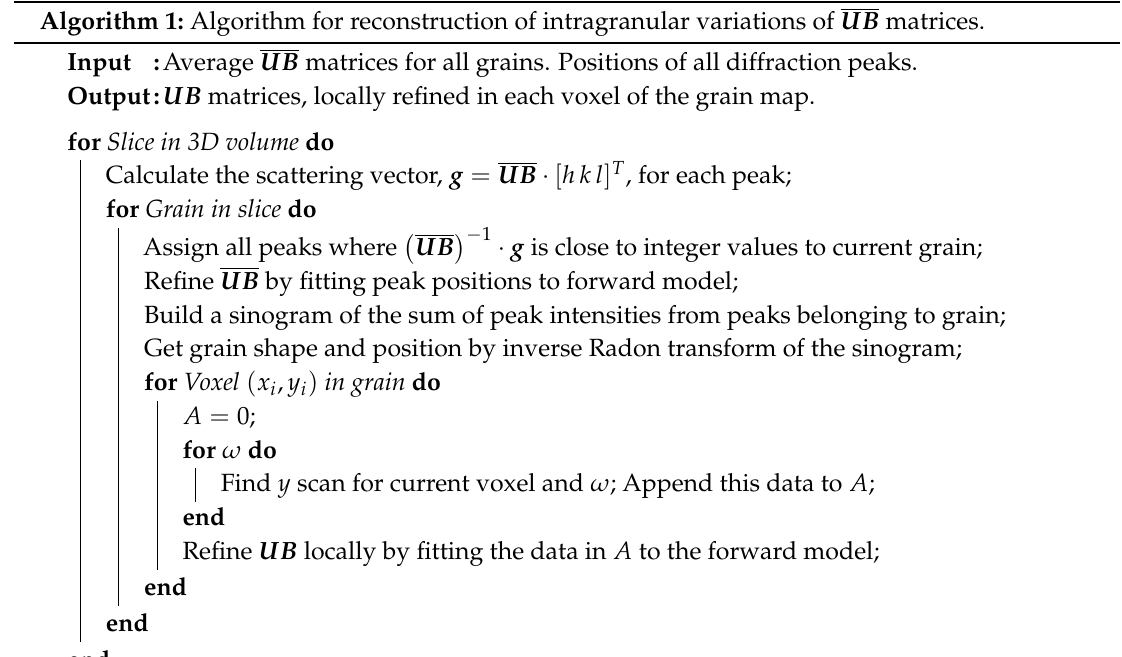
Algorithm 1: Algorithm for reconstruction of intragranular variations of UB